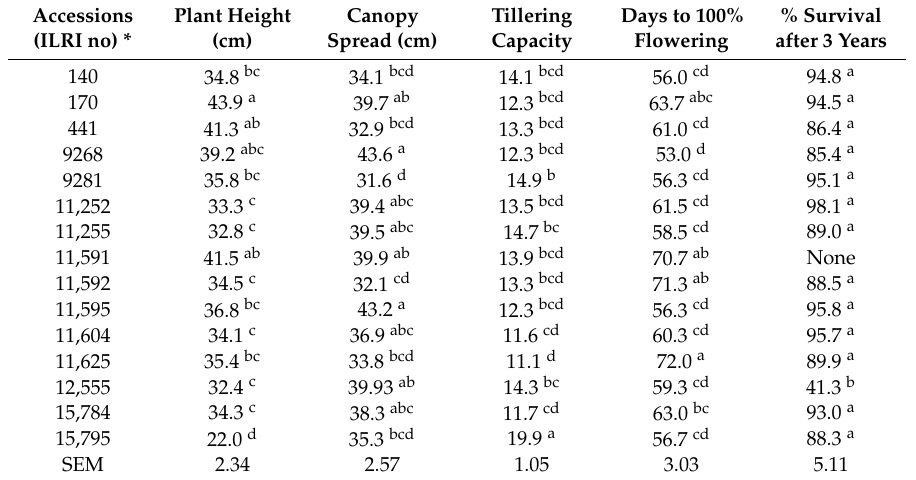
Table 3. Growth performance of S. scabra accessions evaluated in climatic condition of, Pretoria.